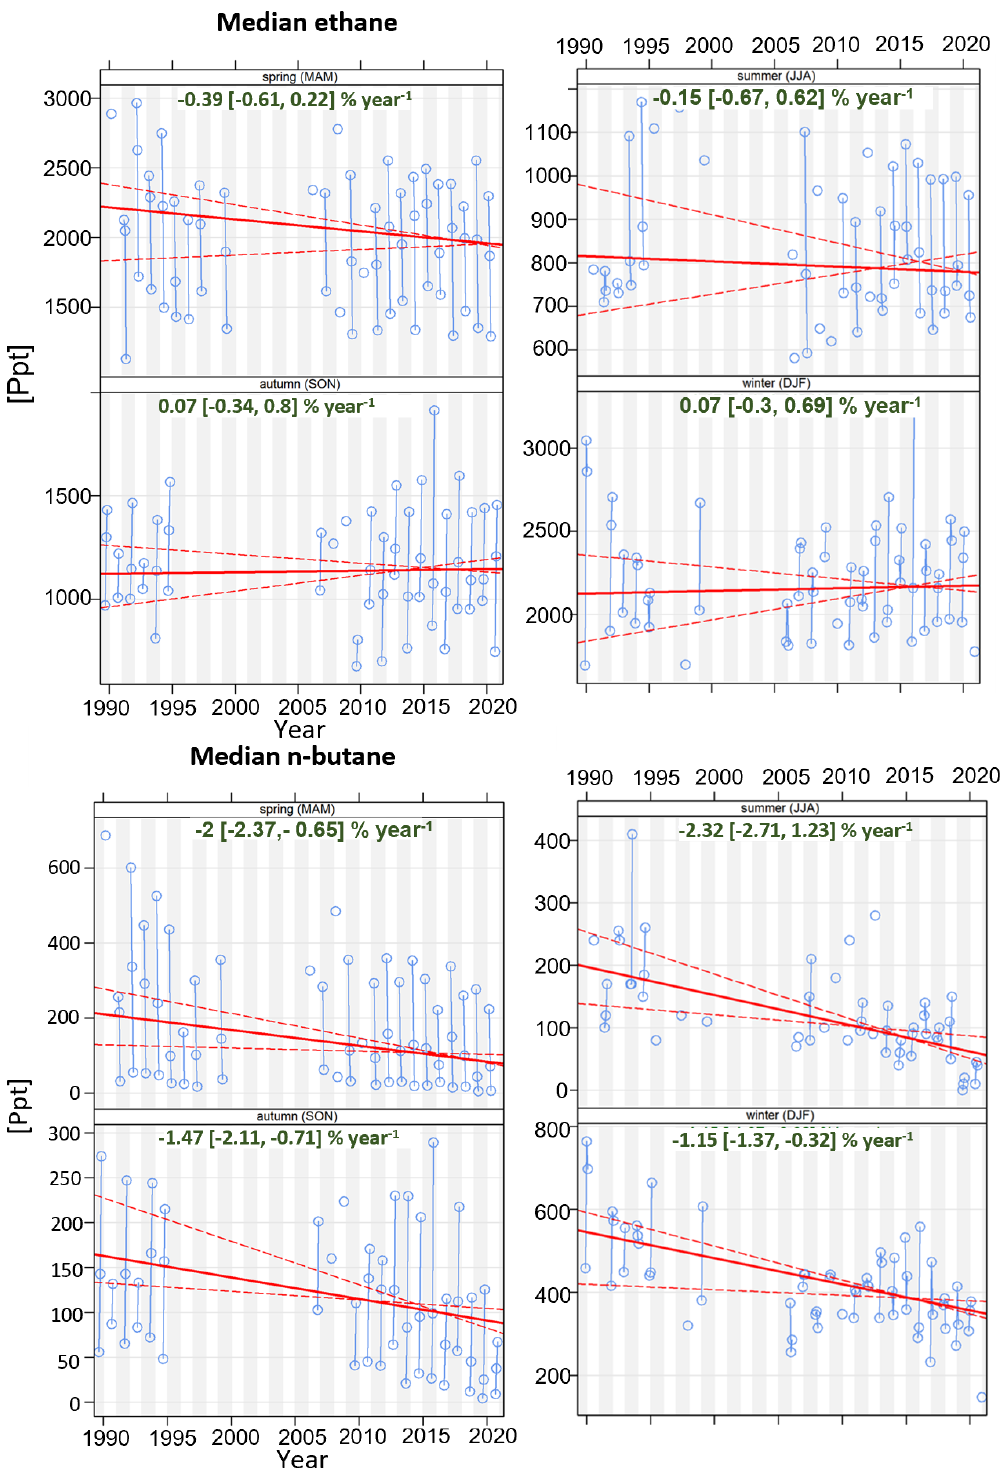
Figure 15. Seasonal Theil–Sen slopes (red) and confidence intervals (dashed, red) based on monthly median concentrations (blue) of ethane and n -butane at the Zeppelin